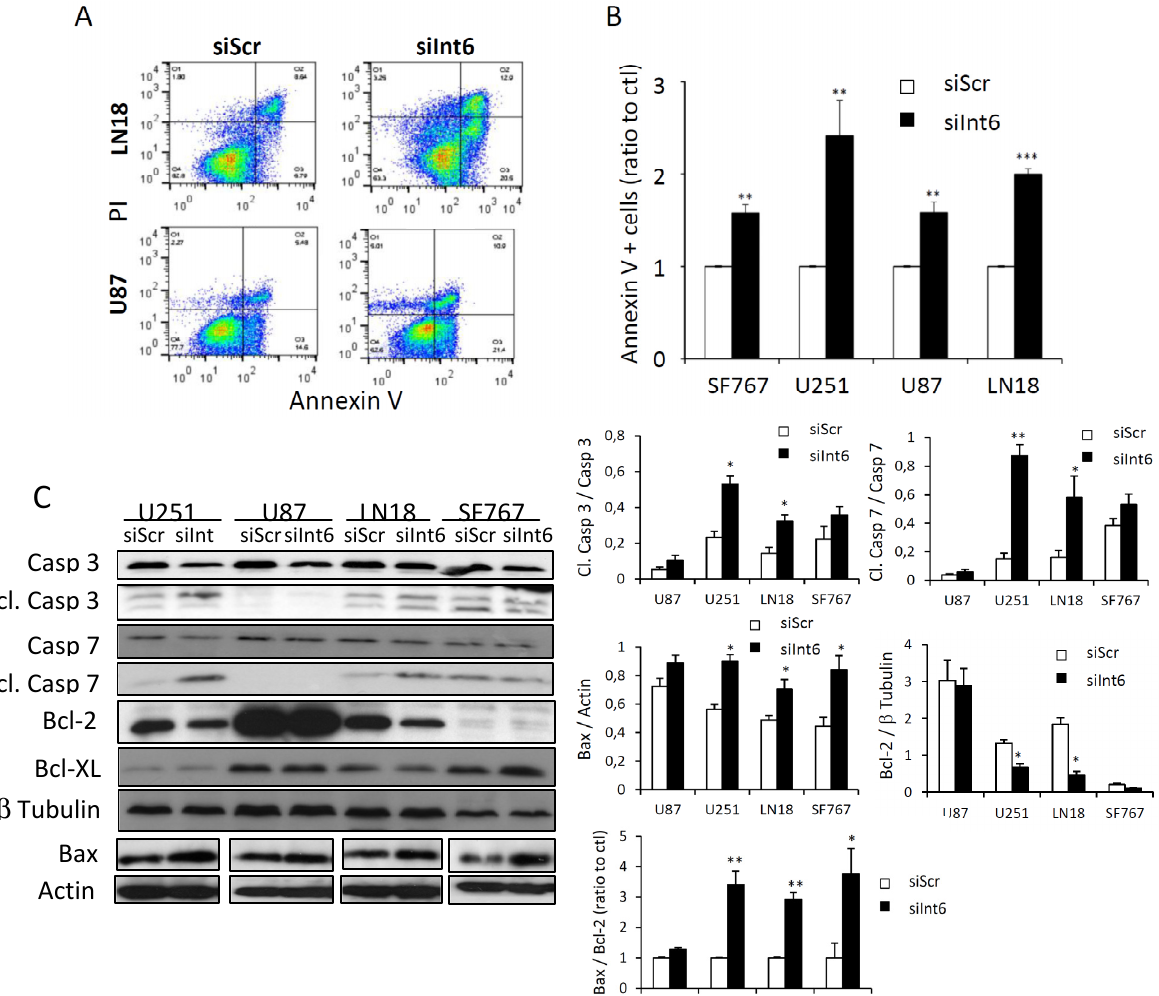
Figure 5. Int6 gene silencing induces cell apoptosis. ( A ) Dot plot representing the percentage of Annexin V positive cells in two GBM cell lines (LN18 and U87) analyzed by flow cytometry and Annexin V/Propidium Iodide staining; ( B ) Quantification of Annexin V positive cells. Int6 inhibition (siInt6) results in a significant increase in apoptotic cells (** p < 0.01, *** p < 0.001 compared with the negative control, siScr, n = 5); ( C ) Western Blot analysis and quantifications of caspase 3, cleaved caspase 3, caspase 7, cleaved caspase 7, Bcl-2, Bcl-XL and Bax expression in LN18, SF767, U87 and U251 GBM cells transfected with siInt6 or siScr. Int6 silencing slightly increases Bax expression, reduces Bcl-2, caspase 3 and caspase 7 expression, and increases Bax/Bcl-2 ratio and cleaved caspase forms for U251 and LN18 cells (* p < 0.05, ** p < 0.01, n = 3); ( D ) Photographs representing glioma cells transfected with siScr or siInt6 and treated with 30 µM of Z-VAD caspase inhibitor (+Z-VAD) or DMSO ( − Z-VAD). Z-VAD treatment partly rescues the deleterious effect of Int6 silencing ( n = 3), scale bars: 20 µm; ( E ) Quantification of Annexin-V/PI staining analyzed by flow cytometry of glioma cells transfected with siScr or siInt6 and treated or not with Z-VAD caspase inhibitor. Z-VAD treatment partly reverses glioma cell death induced by Int6 inhibition (* p < 0.05, n =